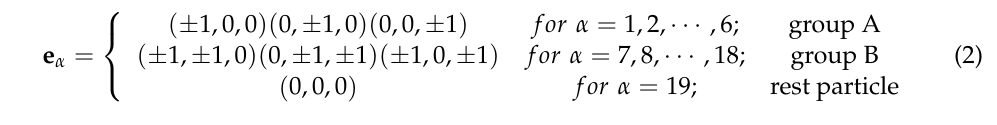
Figure 2. D3Q19 model for the LBM approach.